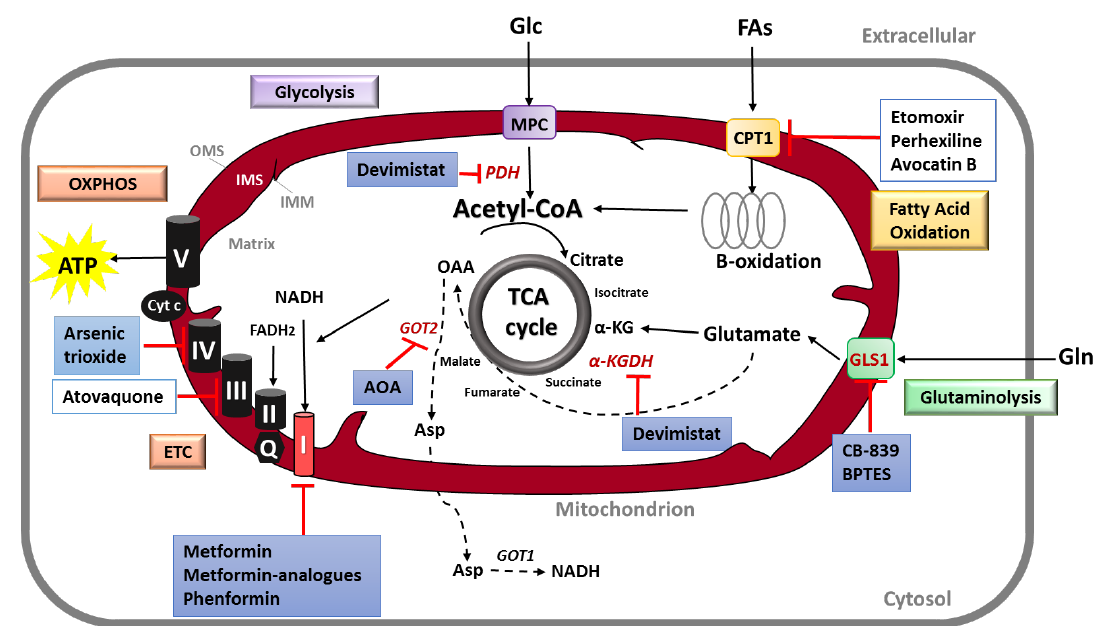
Figure 3. Targeting mitochondrial metabolism in PDAC. Several strategies have been developed to target mitochondrial metabolism in cancer. Compounds that target the ETC and OXPHOS function are an important target in cancer therapy. Among these, molecules that inhibit the mitochondrial Complex I such as the biguanides Metformin and Phenformin are the most frequent described. Other OXPHOS inhibitors are Arsenic trioxide and Atovaquone, targeting CIV and CIII, respectively. Other therapeutic strategies include the targeting of glutamine and fatty metabolism uptake, by inhibiting the enzymes that allow the entry of the molecules to mitochondria (GLS1 and CPT1 for glutamine and fatty acids, respectively). Another way to target mitochondrial metabolism is by suppressing a specific route of PDAC for metabolize glutamine: The transamination. The use of aminooxyacetate (AOA), a pan-inhibitor of transaminases, is able to inhibit the mitochondrial enzyme GOT2. Finally, the inhibition of TCA cycle intermediates is another strategy for cancer